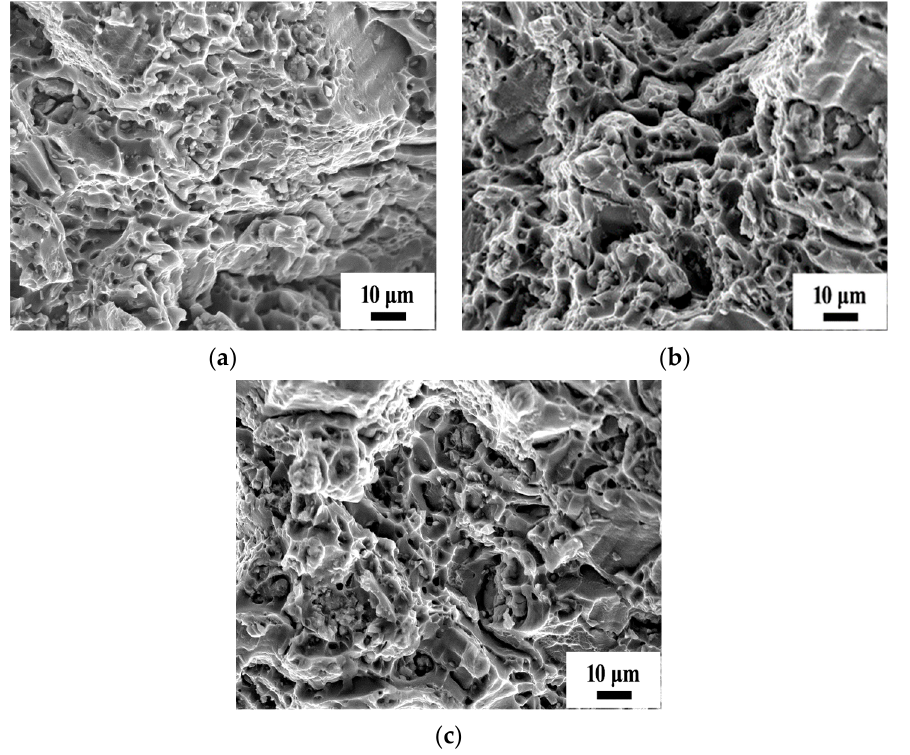
Figure 7. Tensile fracture morphology of alloys in solid solution + aging at room temperature: ( a ) solution + aging 18 h; ( b ) solution + aging 24 h; ( c ) solution + aging 36 h.